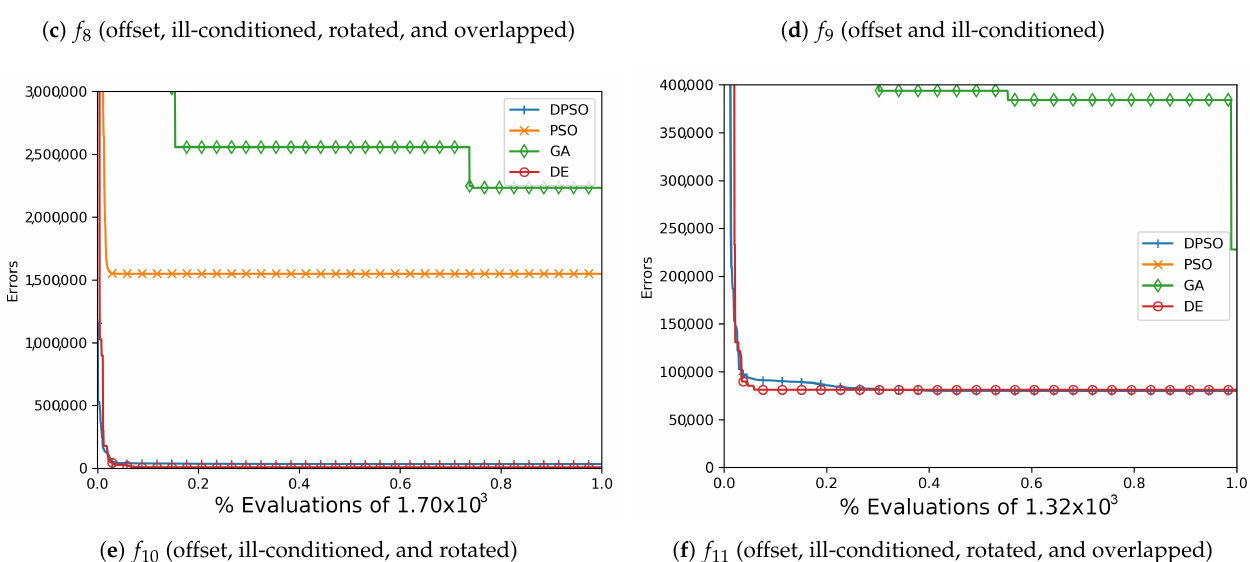
Figure A5. The average Ackley ( f 6 , f 7 , f 8 ) and Rosenbrock ( f 9 , f 10 , f 11 ) global best results over time for 14